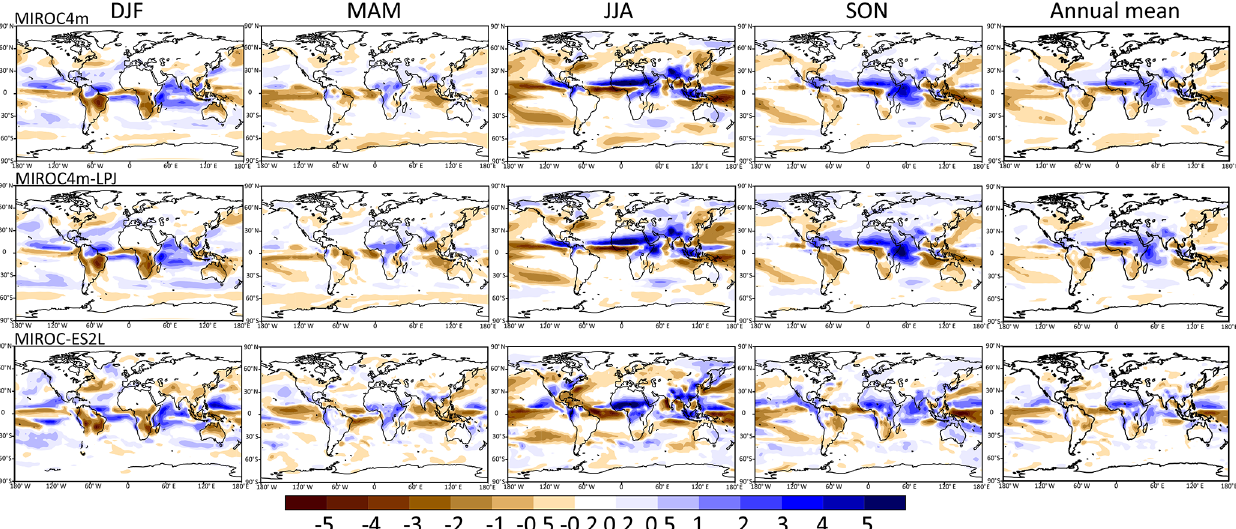
Figure 9. The annual and seasonal precipitation change (mmd − 1 ) in 127k from PI is shown. The calendar for 127k is adjusted using a method based on Bartlein and Shafer